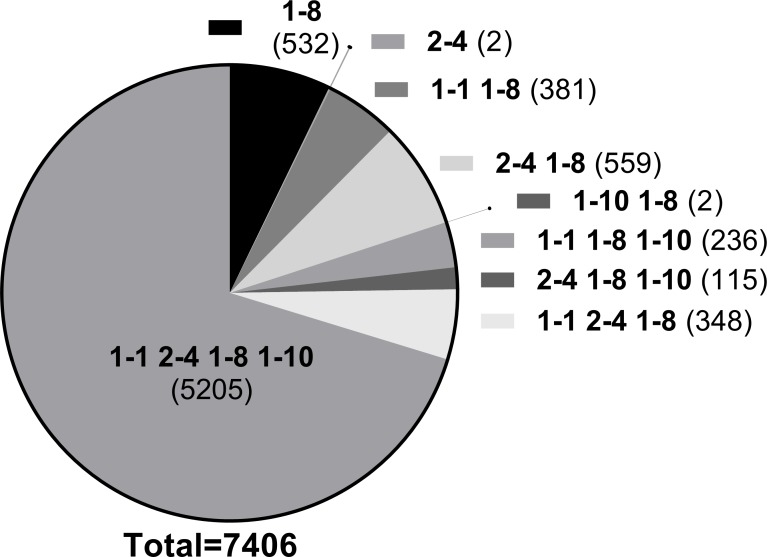
Distribution of active sequences derived from dolphin DQ proteins from the IRL.Sequences with a binding affinity below 10,000nM for each of the datasets for the four proteins (DQ1-1, DQ1-8, DQ1-10 and DQ2-4) from dolphins in the Indian River Lagoon and adjacent Atlantic coast were compiled and the frequency of sequences identified uniquely binding to one protein or shared by 2, 3 or all 4 proteins is shown.